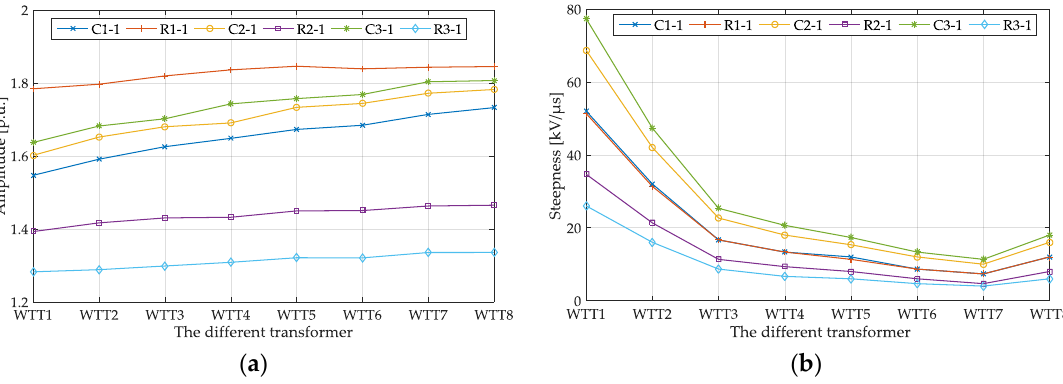
Figure 12. The overvoltages for different transformers when the number of running feeders changes: ( a ) amplitude; ( b ) steepness.